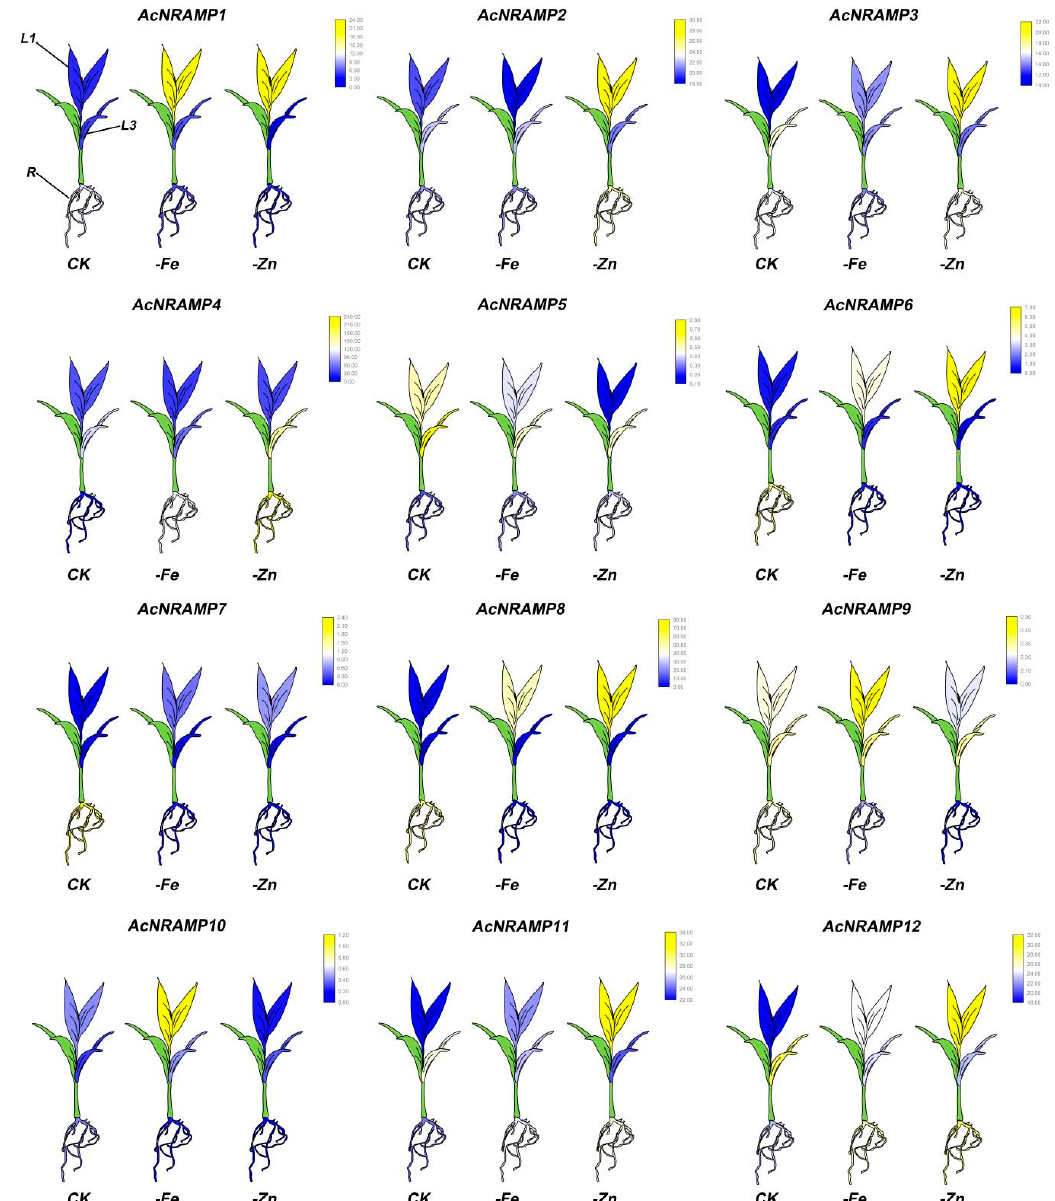
Figure 8. The expression patterns of 12 AcNRAMP genes of A. catechu in Fe and Zn deficiency. FPKM values were obtained by RNA-seq. Each gene has three cartoon heatmaps that represent areca seedlings in normal, Fe-deficient, and Zn-deficient conditions. The sampling mainly targeted the first leaf (L1), third leaf (L3), and root (R) of areca seedlings.